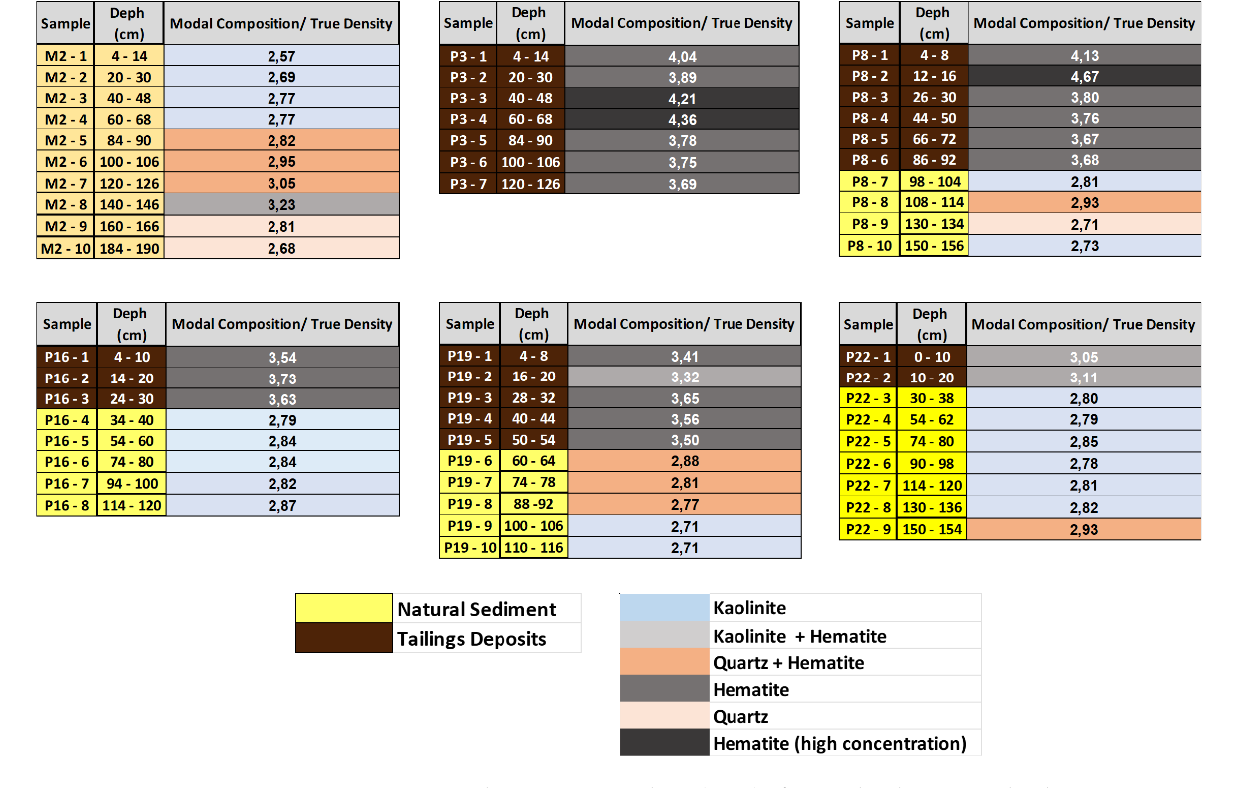
Figure 13. Principal component analysis (PCA) of natural sediments and tailings. Tailings deposits on the other hand, are characterized by high-density values, above 3.5 g/cm 3 , with predominant associations of hematite, hematite (high concentration) and kaolinite +